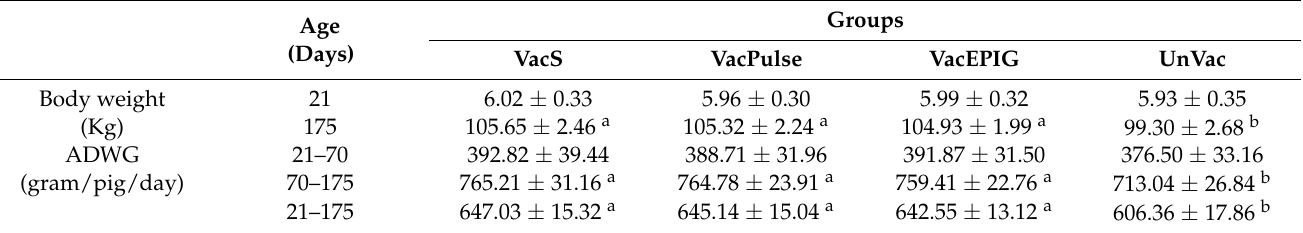
Table 2. Body weight and average daily weight gain (ADWG) data (mean ± standard deviation) from vaccinated and unvaccinated